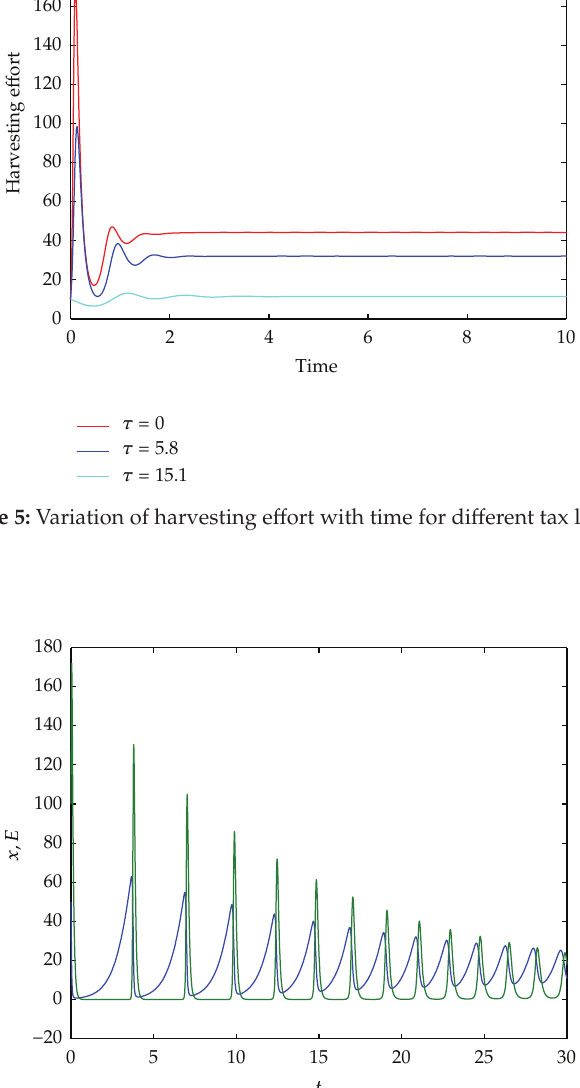
Figure 6: The trend of population x (cid:4) t (cid:5) and E (cid:4) t (cid:5) in the tax τ δ (cid:6) 15 . 1 rates when the reserved zone not set